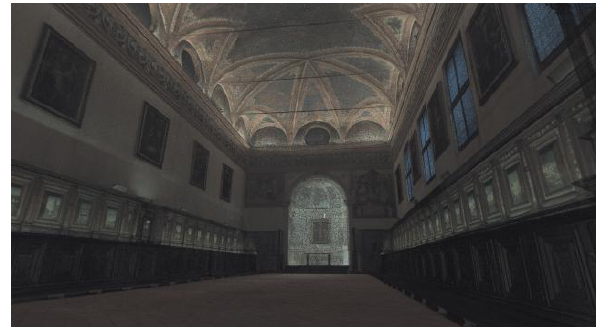
Figure 4. Point cloud of the Old Sacristy, acquired by the Leica P30 laser scanner with activated camera.